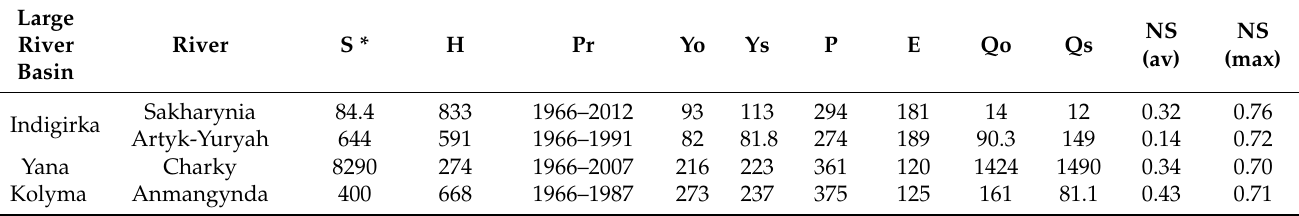
Table 3. The characteristics of the simulated watersheds and modelling